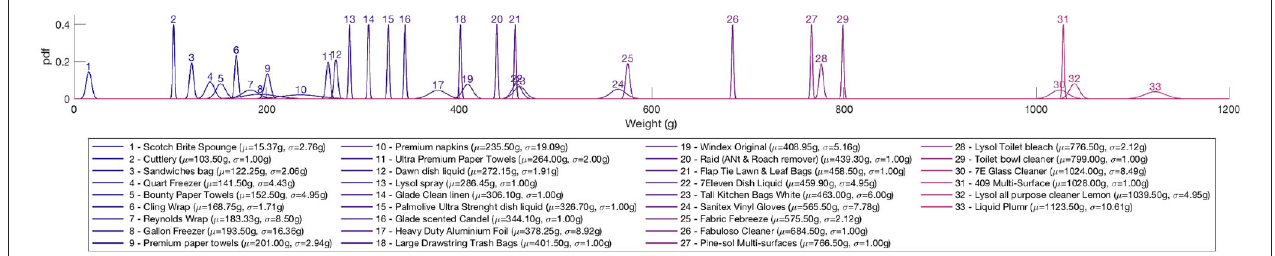
FIGURE 5 | Weight distribution of each product used in our experiments.